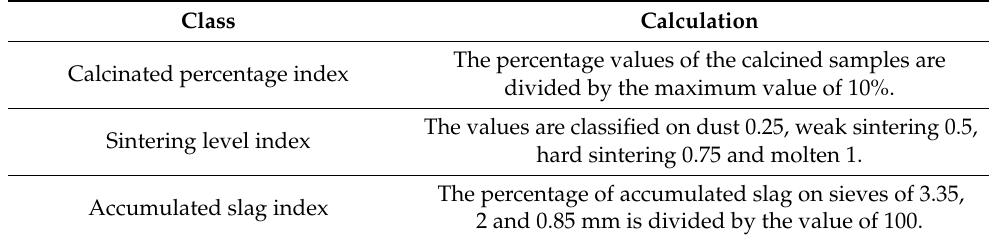
Table 4. Slag severity calculation based on the BioSlag Test.